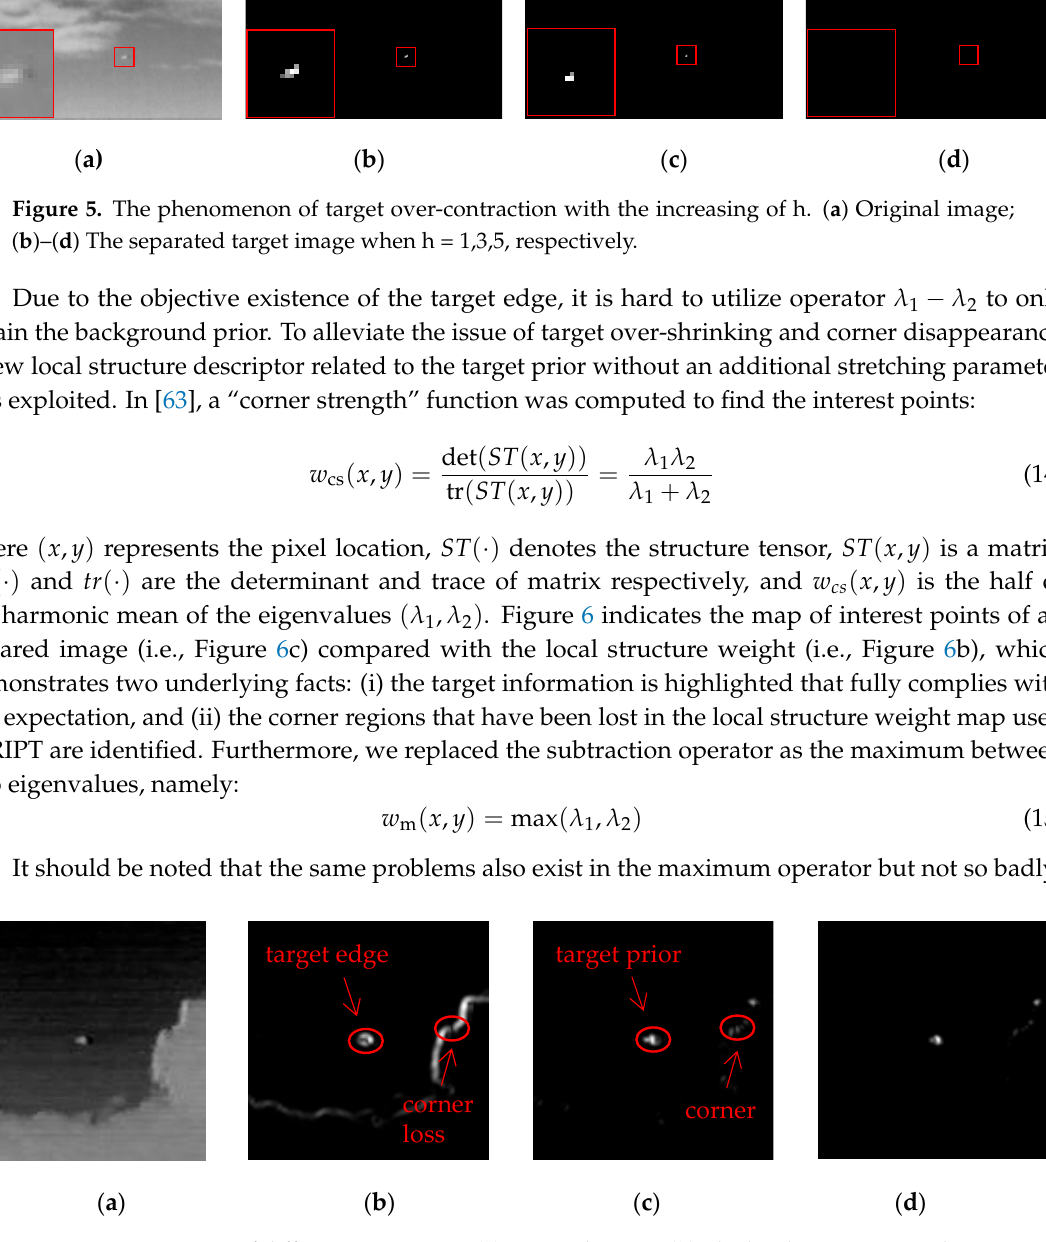
Figure 6. Comparison of different prior maps. ( a ) Original image; ( b ) The local structure weight map used in RIPT (calculated by Equation (13)); ( c ) The corner strength map (calculated by Equation (14)); ( d ) The prior weight map used in the proposed model (calculated by Equation (16)).